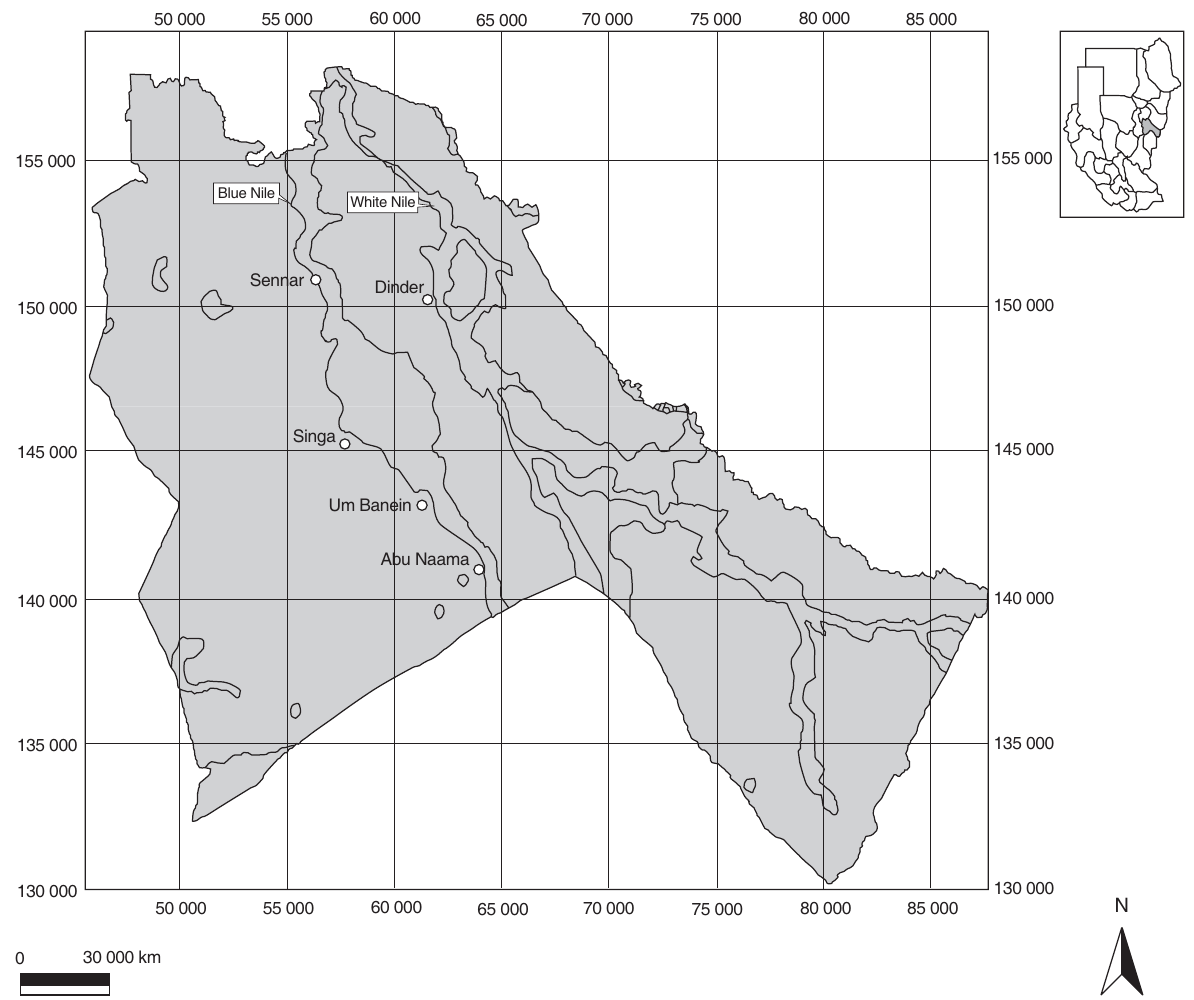
FIG. 1 Map of Sennar State showing localities at which samples were